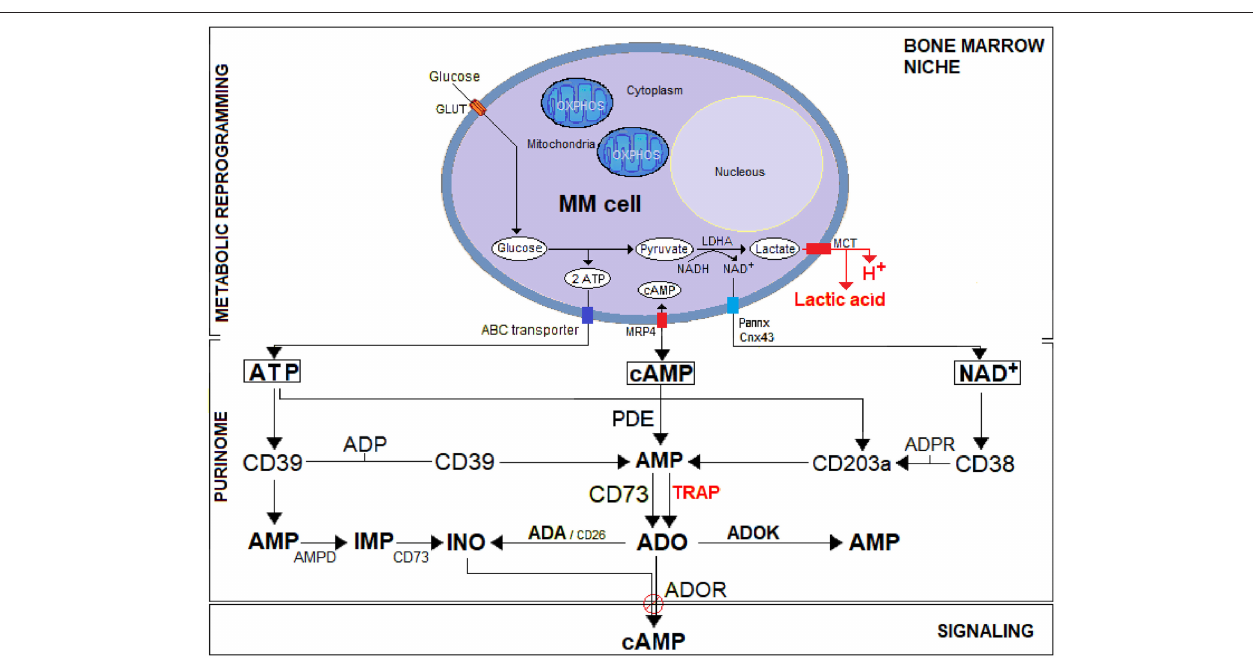
FIGURE 1 | A schematic representation of the purinome in the MM environment under bone marrow niche metabolic reprogramming. Unlike normal cells, tumor cells (i.e., MM) utilize glycolysis instead of OXPHOS for metabolic reprogramming: most of the resulting pyruvate is catalyzed by lactate dehydrogenase A (LDH-A) to lactic acid simultaneously producing protons (H + ). The efflux of lactic acid and H + induces lactic acidosis generating an acidic TME (pH < 6.5). Cytoplasmic ATP, cAMP, and NAD + actively secreted across nucleotide transporters (e.g., ABC transporter, Pannexin/Connexin channels, MRP4) or passively after cell lysis, are metabolized in the hypoxic acidic BM niche to ADO. The purinome (e.g., complex network of nucleotidic substrates, ectonucleotidases, signaling by-products, and purinergic receptors) operating in the BM niche exploit the classical pathway (CD39/CD73) for ATP substrate and the (CD38/CD203a/CD73) pathway for NAD + , flanked by an alternative (PDE/CD73) pathway that converts cAMP to AMP for generating the immunosuppressive ADO. Generated ADO binds to P1 purinergic ADO receptors (ADOR) and activates adenylyl cyclase, which catalyzes the formation of the intracellular second messenger cAMP. Eventually, ADO can also be inactivated at the cell surface by an ADA/CD26 complex that converts it into inosine (INO) or internalized by nucleoside transporters. The extracellular ATP breakdown follows under physiological conditions the classical ATP/ADP/AMP/ADO adenosinergic pathway. However, the presence of high ATP concentration in the TME lead AMP to